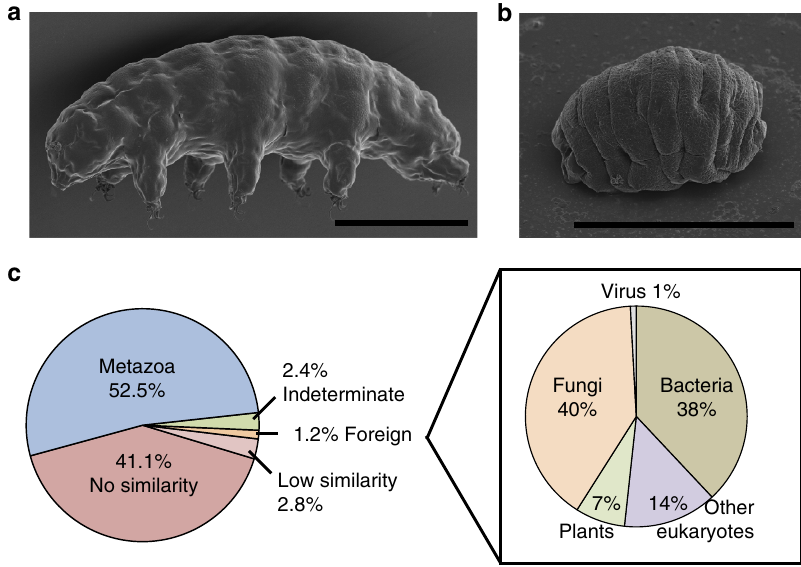
Figure 1 | The extremotolerant tardigrade R. varieornatus and taxonomic origins of its gene repertoire. ( a , b ) Scanning electron microscopy images of the extremotolerant tardigrade, R. varieornatus , in the hydrated condition ( a ) and in the dehydrated state ( b ), which is resistant to various physical extremes. Scale bars, 100 m m. ( c ) Classification of the gene repertoire of R. varieornatus , according to their putative taxonomic origins and distribution of best-matched taxa in putative HGT